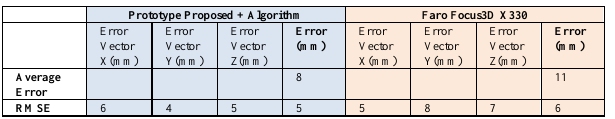
Table 2. Comparison of errors between the systems compared: proposed system and the Faro Focus3D X330 laser